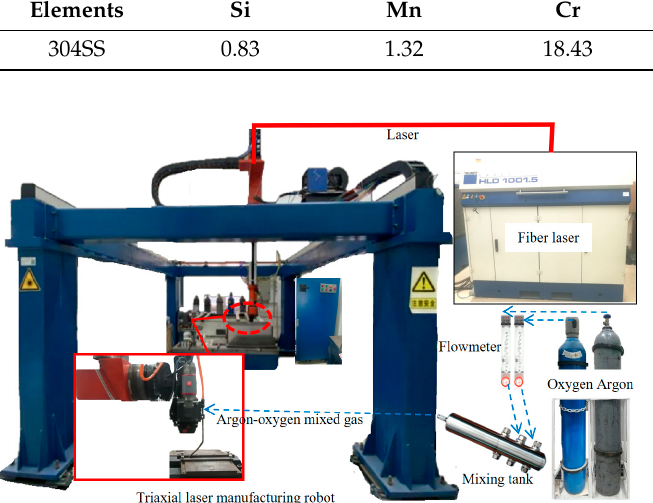
Table 1. Chemical composition of the 304SS plate (atomic fraction (%)).